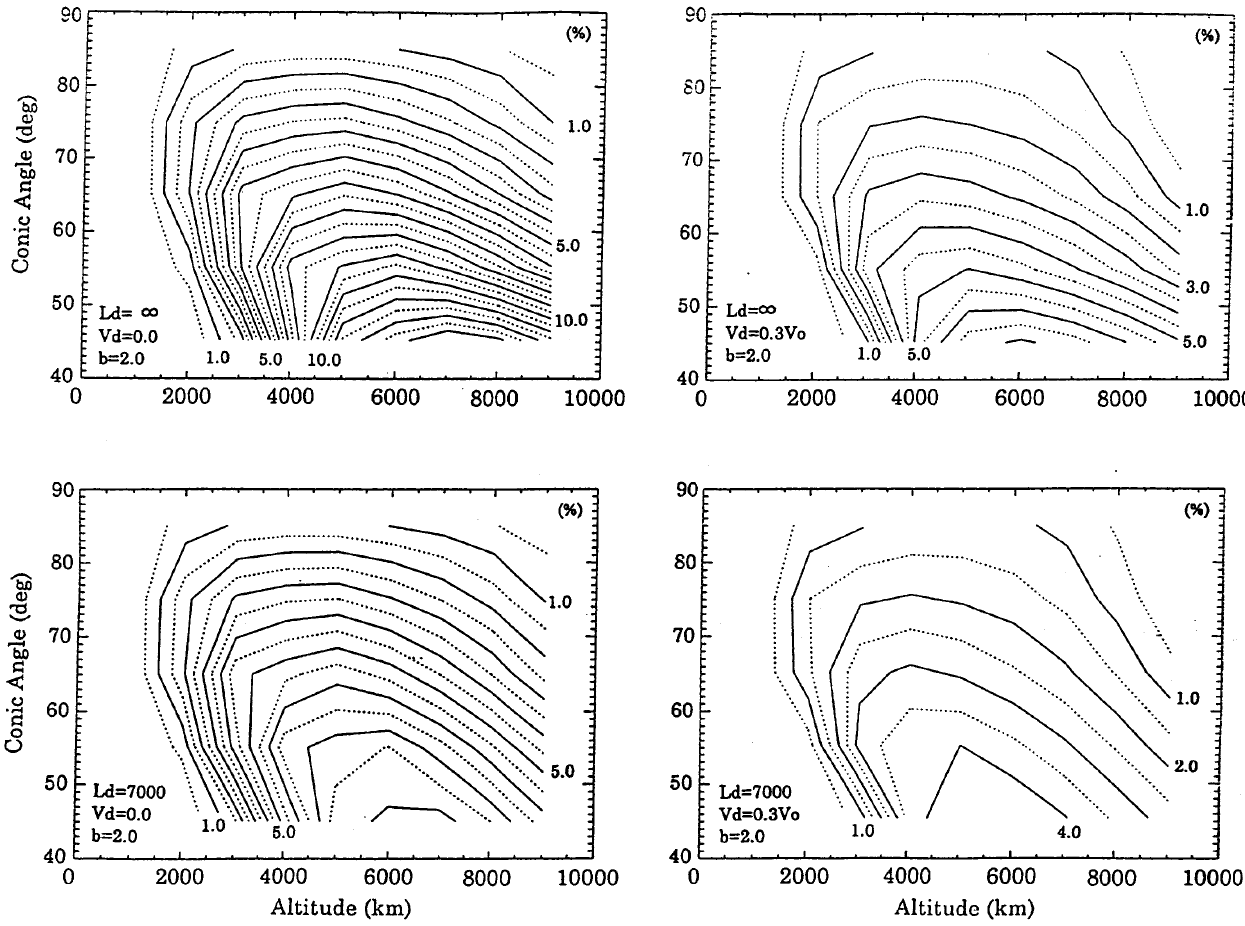
Fig. 4. Four examples of calculated occurrence frequencies as a function of altitude and conic angle under adiabatic motion (cid:133) b (cid:136) 2 : 0 (cid:134) . The occurrence frequencies of conics with a conic angle of 85 (cid:14) are adjusted to the observation